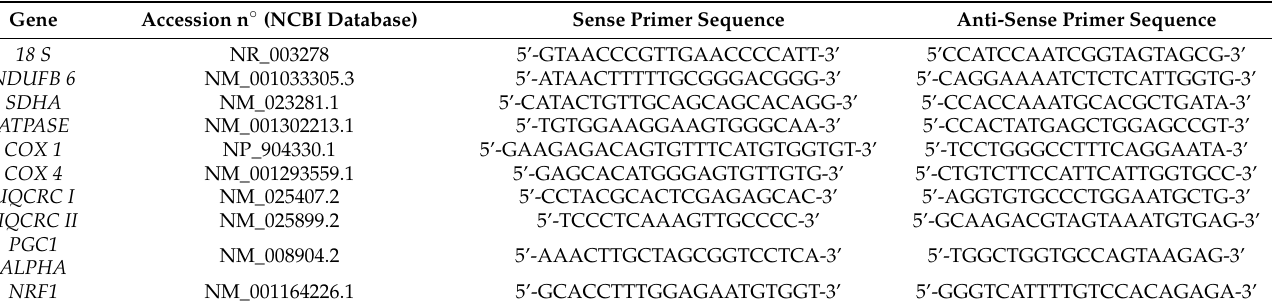
Table 1. Primer sequences for Real-Time